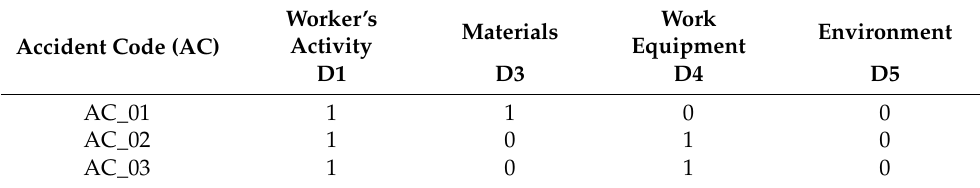
Table 4. Matrix of descriptors (excerpt).